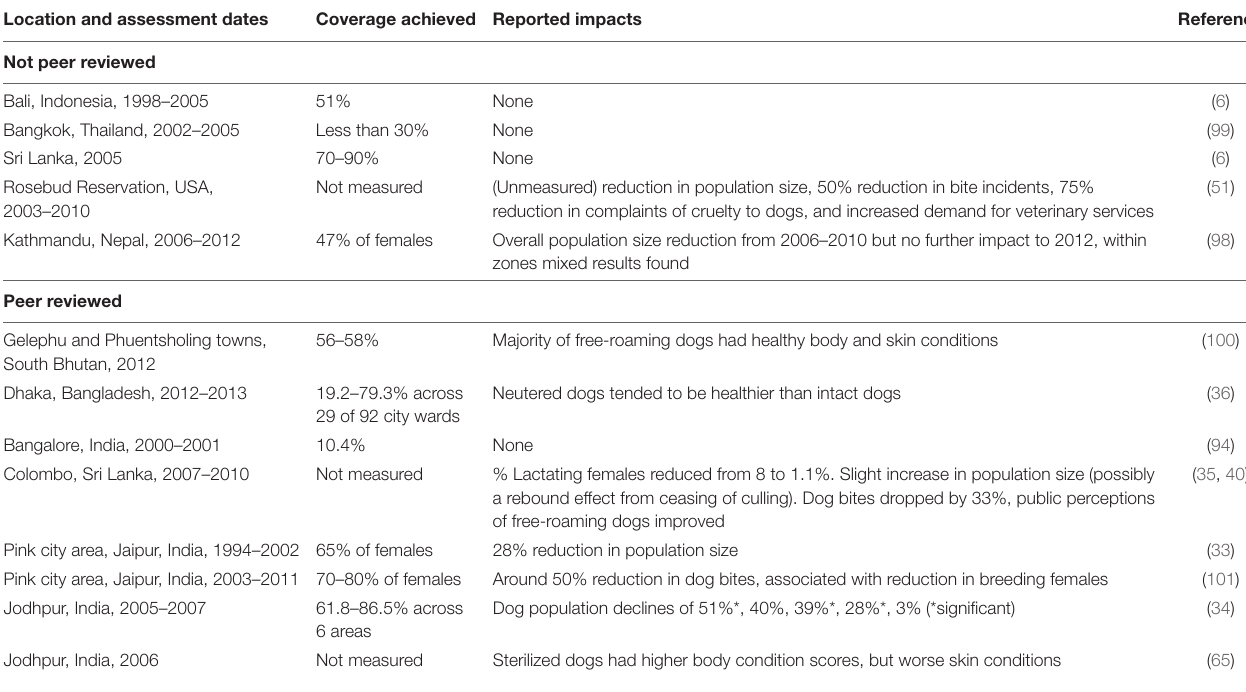
TABLe 3 | Available information on impacts of surgical sterilization programs on dog population